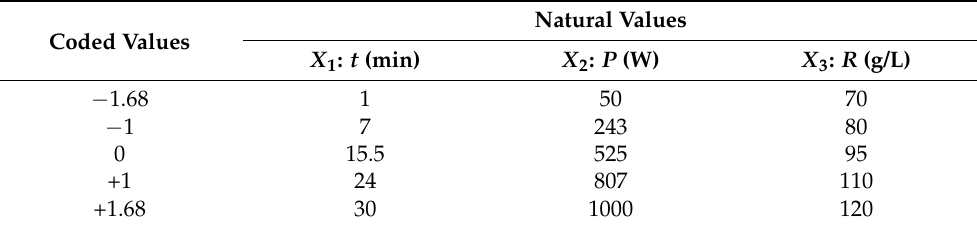
Table 1. Natural and coded values of the independent variables used in the CCRD to optimize the MAE of oil from fish by-products. Natural Values Coded Values X 1 : t (min) X 2 : P (W) X 3 : R (g/L) − 1.68 1 50 70 − 1 7 243 80 0 15.5 525 95 +1 24 807 110 +1.68 30 1000